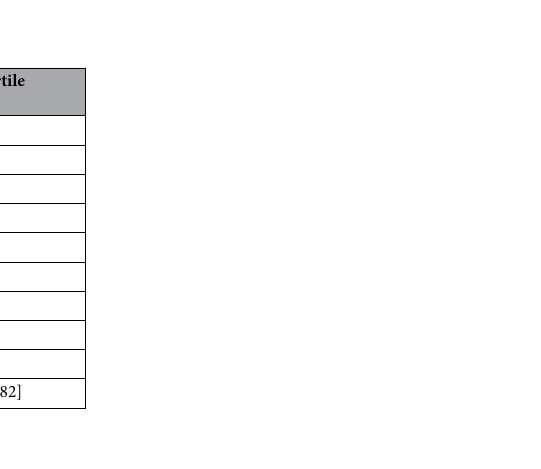
Table 1. Participant demographics. Demographics and clinical variables of participants who completed the MRI scans. GA gestational age, IQR interquartile range, IVH intraventricular hemorrhage.